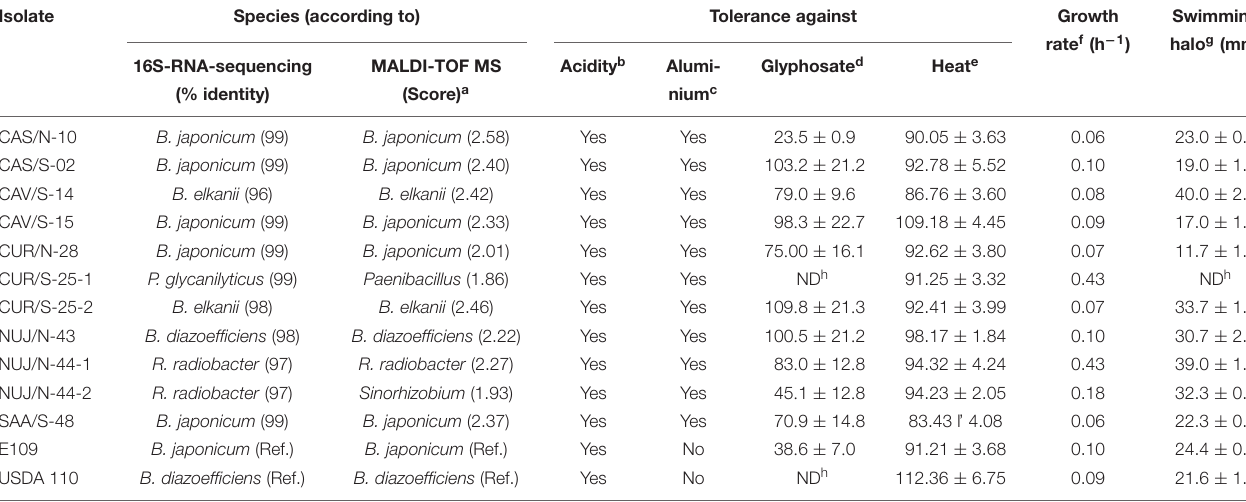
TABLE 2 | Species determination and relevant properties of SNAP-isolates and reference strains (Ref.). Isolate Species (according